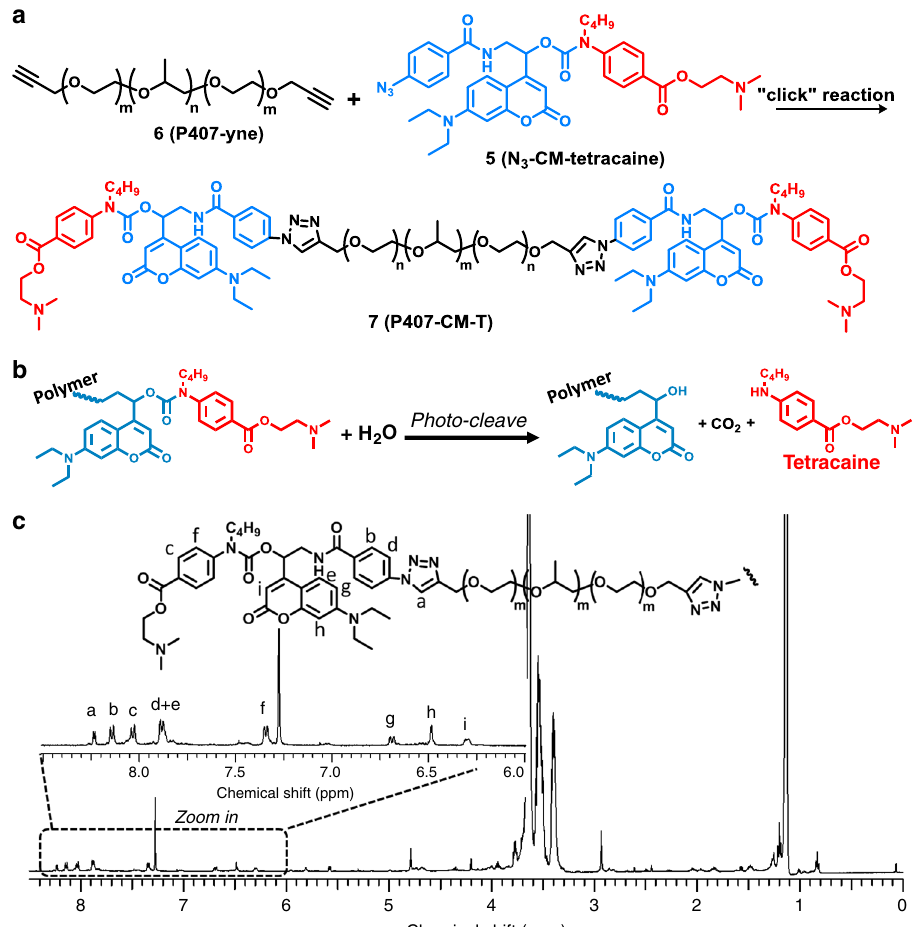
Fig. 1 The light-triggerable tetracaine-polymer prodrug. a .Synthesis of P407-CM-T through alkyne-azide click reaction. b Photo-cleavage reaction of P407-CM-T. c 1 H NMR of P407-CM-T.